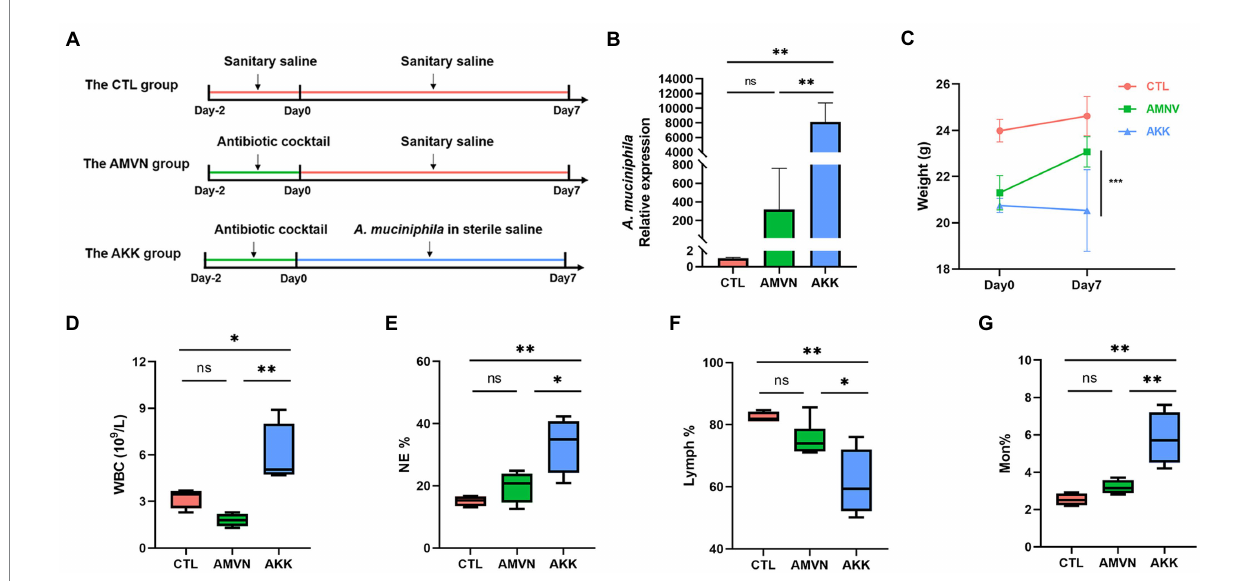
FIGURE 4 Excess colonization of the Akkermansia muciniphila mouse model. (A) Schematic diagram of the experiment. (B) Relative expression of A. muciniphila in mice feces tested by qRT-PCR. (C) Body weights before and after administering A. muciniphila . (D) The quantity of white blood cells (WBC). The percentages of neutrophils (NE) (E) , lymphocytes (Lymph) (F) , and monocytes (Mon) (G) . Data are mean ± SEM; n ≥ 3, “ns,” not significant, * p < 0.05, ** p < 0.005, and *** p <